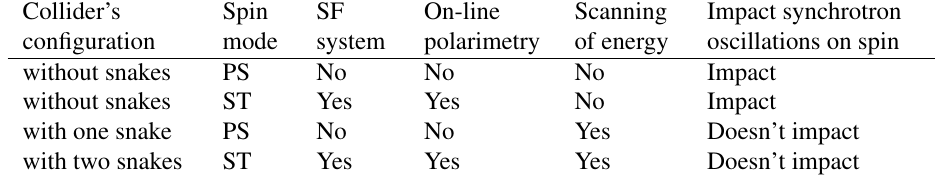
Table 2. Possibilities at the operation with polarized protons and deuterons in the NICA